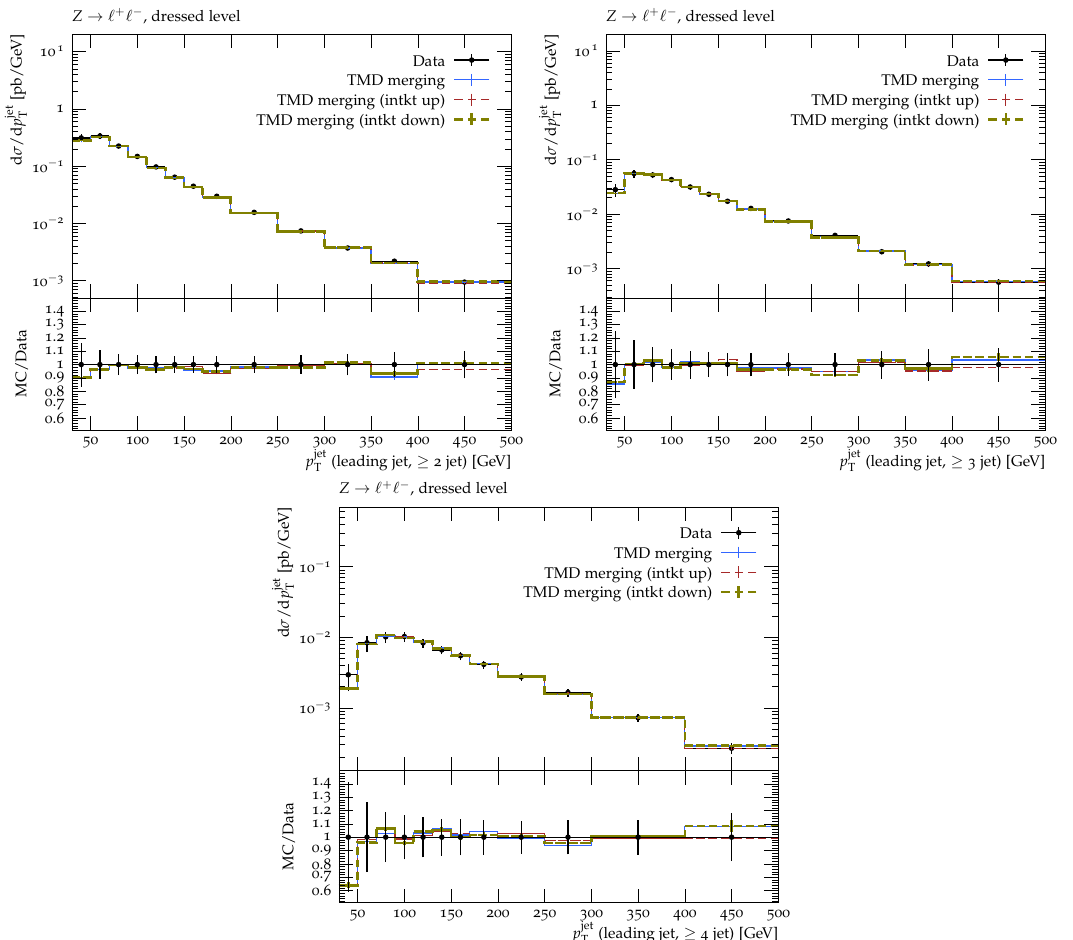
Figure 30 . Leading jet p T spectrum in inclusive Z + 2 (top left), 3 (top right), and 4 (bottom) jets: intrinsic- k T